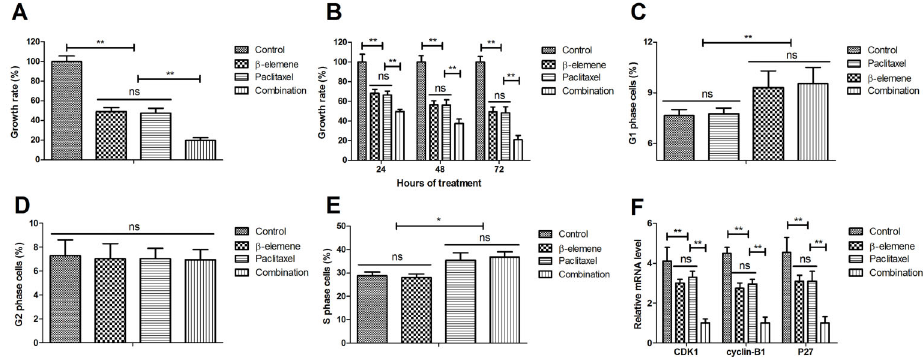
Figure 2. Effect of b -elemene (100 mg/mL), paclitaxel (20 mg/mL), or their combination on cell growth of SKOV3 cells ( A and B ), and on cell cycle ( C to E ). F , Effect of b -elemene and/or paclitaxel on genes CDK1, cyclin-B1, and P27 expression in SKOV3 cells. Data are